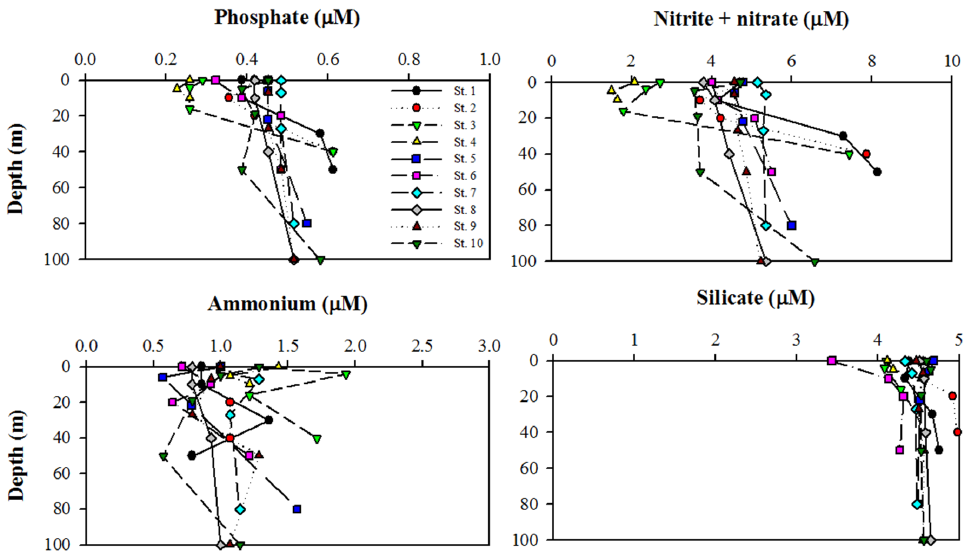
Figure 2. Vertical patterns of phosphate ( µ M), nitrite + nitrate ( µ M), ammonium ( µ M), and silicate ( µ M) concentrations from the surface to the 100-m water depth at sampling stations.